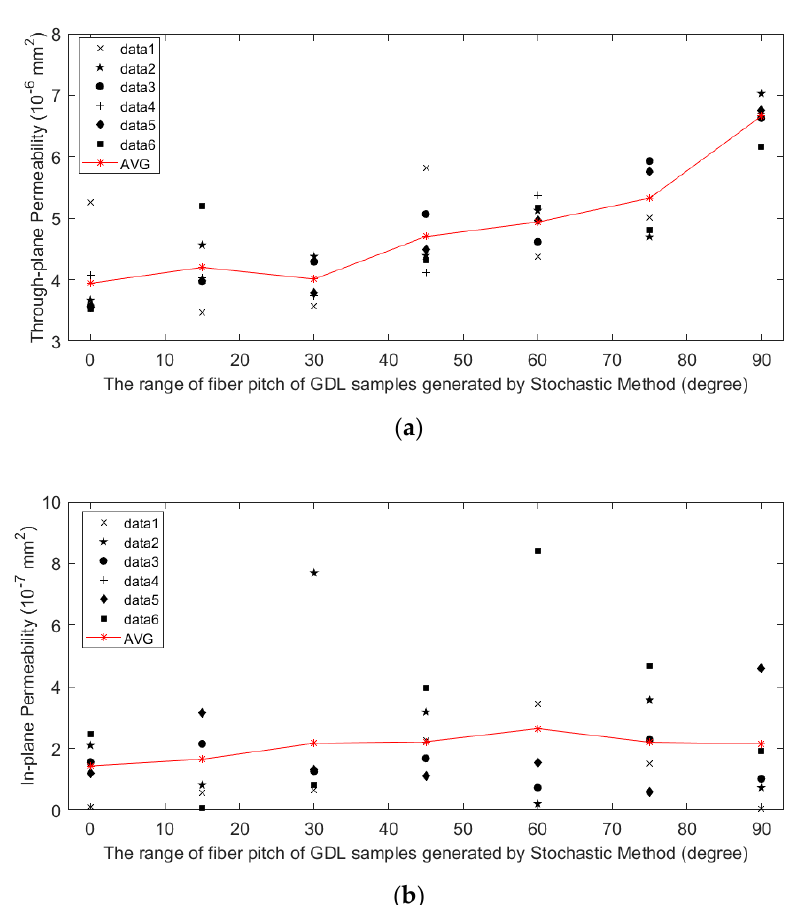
Figure 10. Trend chart of the permeability of GDL with different fiber pitch range, ( a ) through-plane permeability, and ( b ) in-plane permeability.